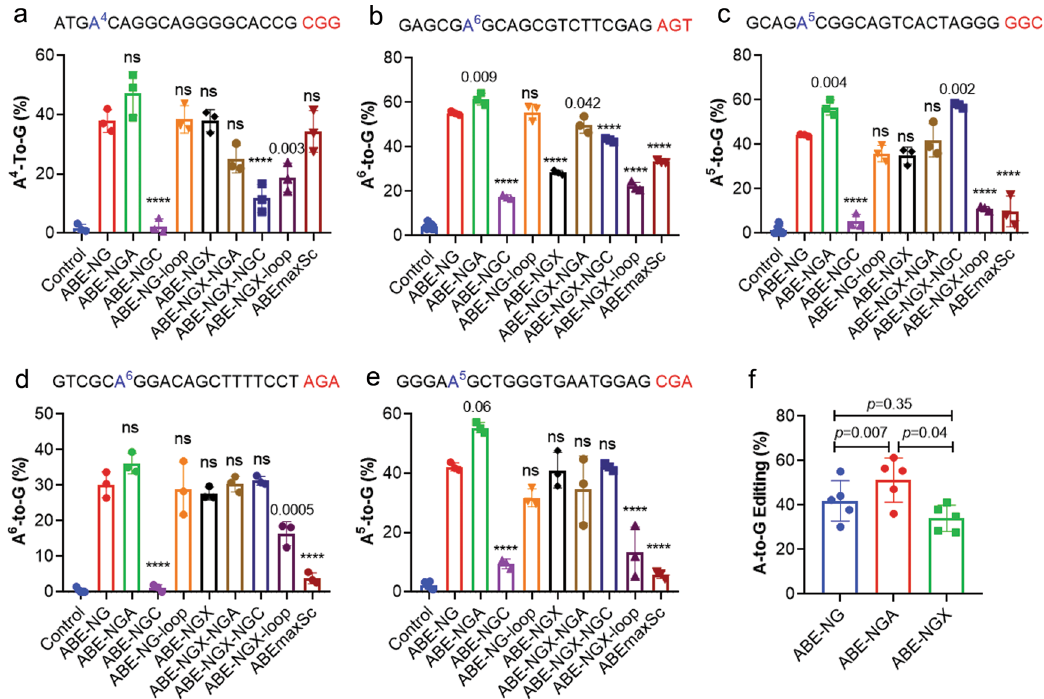
Fig. 2 Optimization of the PAM-interacting domain to improve the editing ef fi ciency of ABE-NG at the NG sites. a – e Measurements of the base editing ef fi ciencies of different ABE variants on fi ve different sites with NG PAM. The gRNA sequences are listed on the top of each graph with the PAM sequences in red and the target adenines in blue. ns not signi fi cant; **** p < 0.0001; one-way ANOVA with Turkey ’ s multiple comparisons test to compare with the ABE-NG group. n = 3 wells/group. Data are mean ± SD. f Comparison of the editing ef fi ciencies of different ABE variants at all fi ve NG sites. n = 5 different sites/group; average of three different wells per site; repeated measures one-way ANOVA with Turkey ’ s multiple comparisons test. Data are mean ±